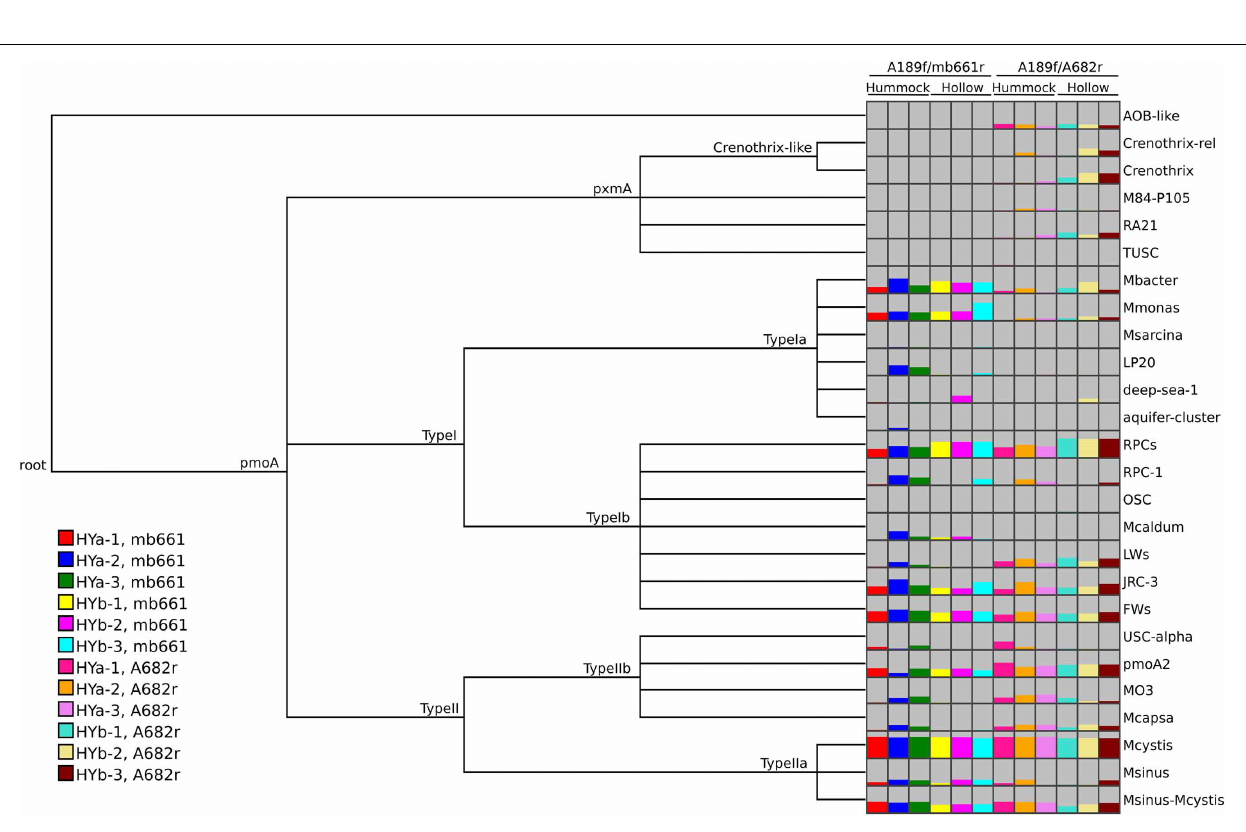
datasets (3309 sequences) was chosen for the comparison. Assignments to internal nodes are not shown. MEGAN only shows taxa detected in at least one sample. The height of the bars was scaled to the number of reads assigned in each dataset and color-coded as indicated in the legend. The labeling at the top of the columns was